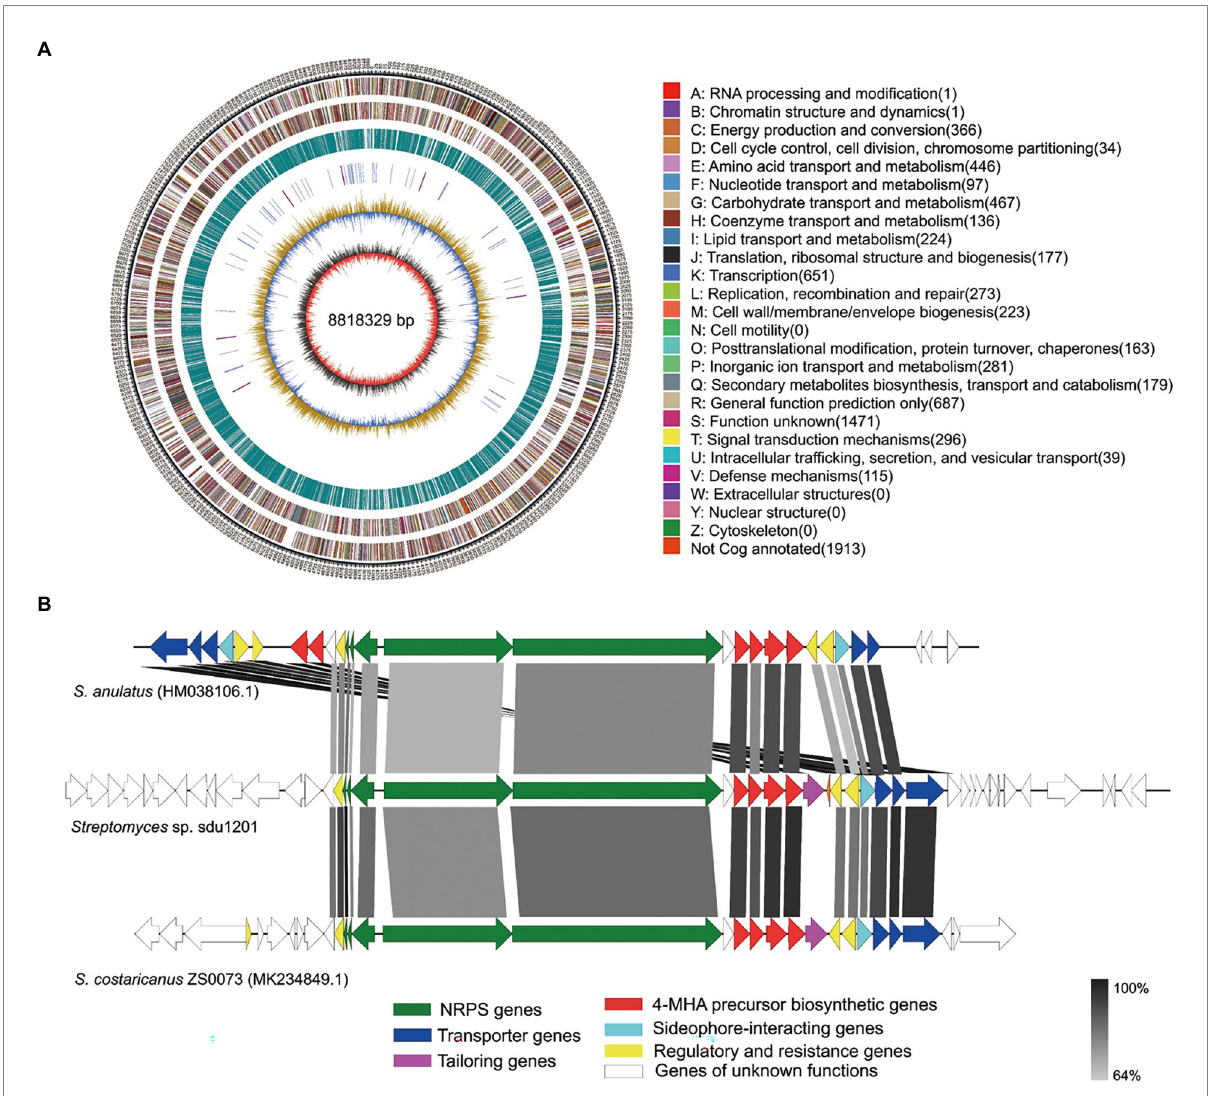
FIGURE 5 Complete genome and actinomycin D BGC of Streptomyces sp. sdu1201. (A) Circular map of genome. The seven circles (outer to inner) represent forward genome size, strand coding sequences, reverse-strand coding sequences, repetitive sequences, transfer RNA (blue) and ribosomal RNA (purple), GC content, and GC skew. (B) Comparison of actinomycin D BGC from Streptomyces sp. sdu1201 (middle) with reference actinomycin D BGC from S. anulatus (top) and S. costaricanus ZS0073